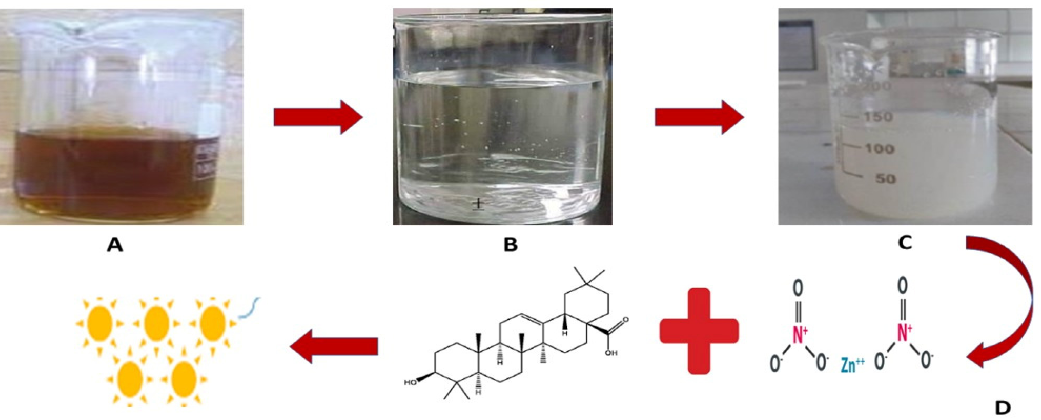
Figure 1. ( A ) Aqueous extract of Monotheca buxifolia. ( B ) Salt solution of zinc nitrate. ( C ) reduction ( D ) Mechanistic approach for the synthesis of ZnO-NPs through plant active compounds.